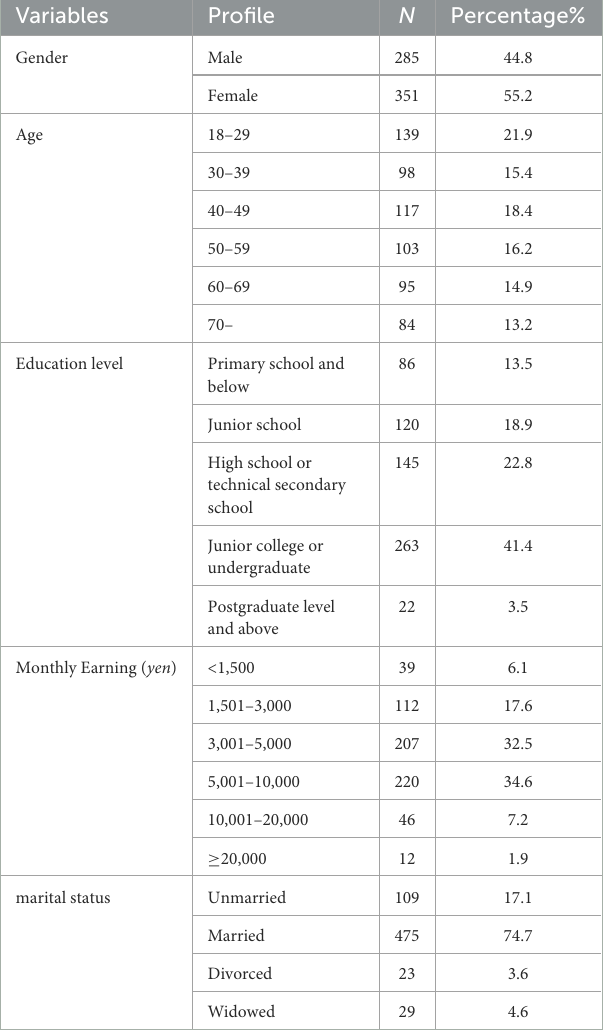
TABLE 1 Sociodemographic characteristics of the whole